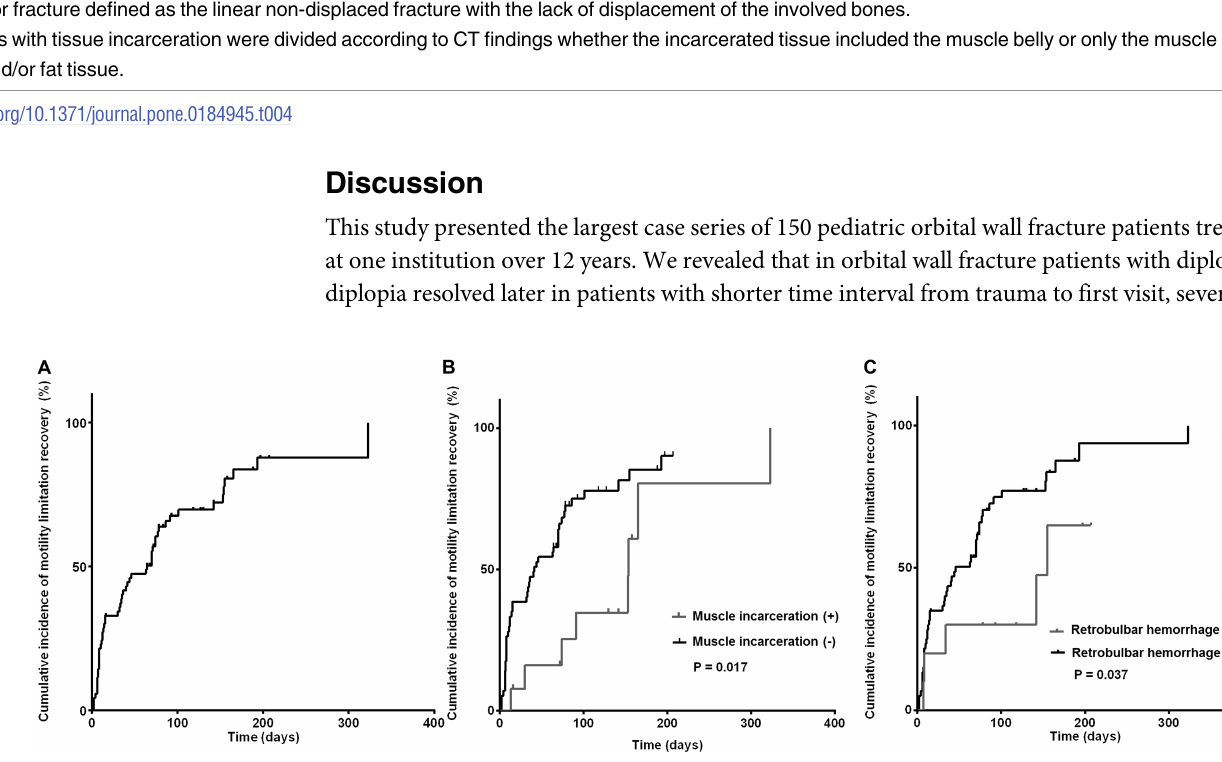
Fig 2. Kaplan-Meier curves of recovery of ocular motility limitation. (A) Cumulative incidenceof resolved ocularmotility in pediatric patients with orbital wall fracture. The cumulativeincidenceof resolvedocular motility at 3 months was 50.0%. In 58 patients (76.3%), ocular motility was finally recovered. (B) Univariateanalyseson risk factors for delayedocular motility limitation. Patients with muscle incarceration experienced more delayedrecovery than those without muscle incarceration.(C) Patients with retrobulbar hemorrhageexperienced more late recovery than those without retrobulbar